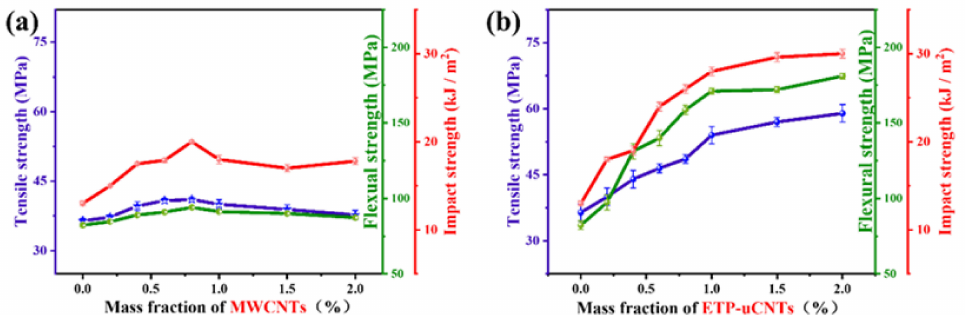
Figure 7. Concentration dependence of mechanical properties (tensile strength, flexural strength and impact strength) for CER-E/MWCNT ( a ) and CER-E/ETP-uCNT ( b ) hybrid